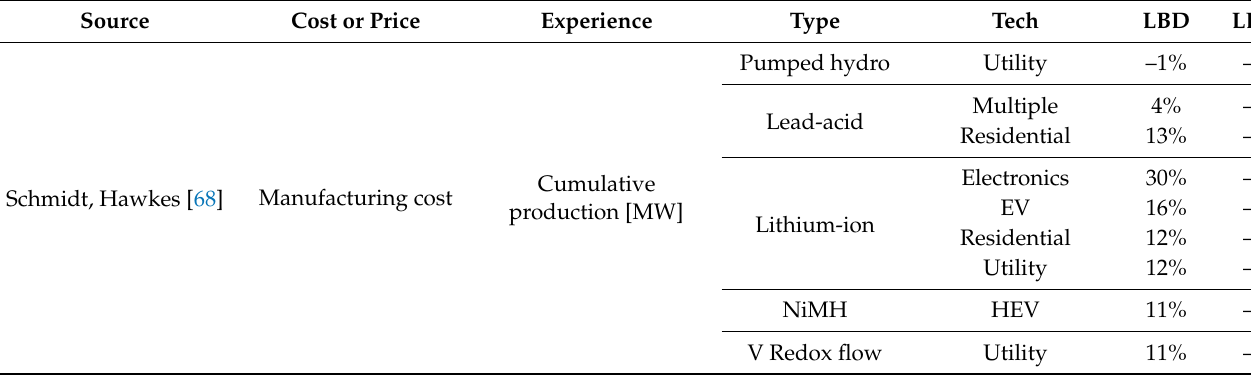
Table A6. LRs for energy storage